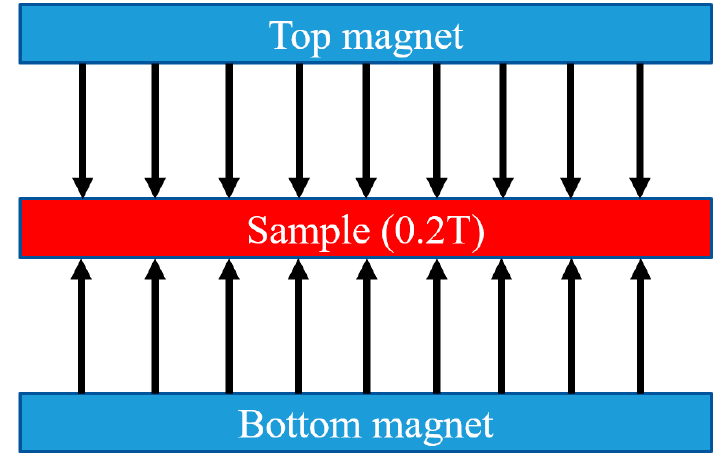
Figure 1. Diagram of the magnetic field.